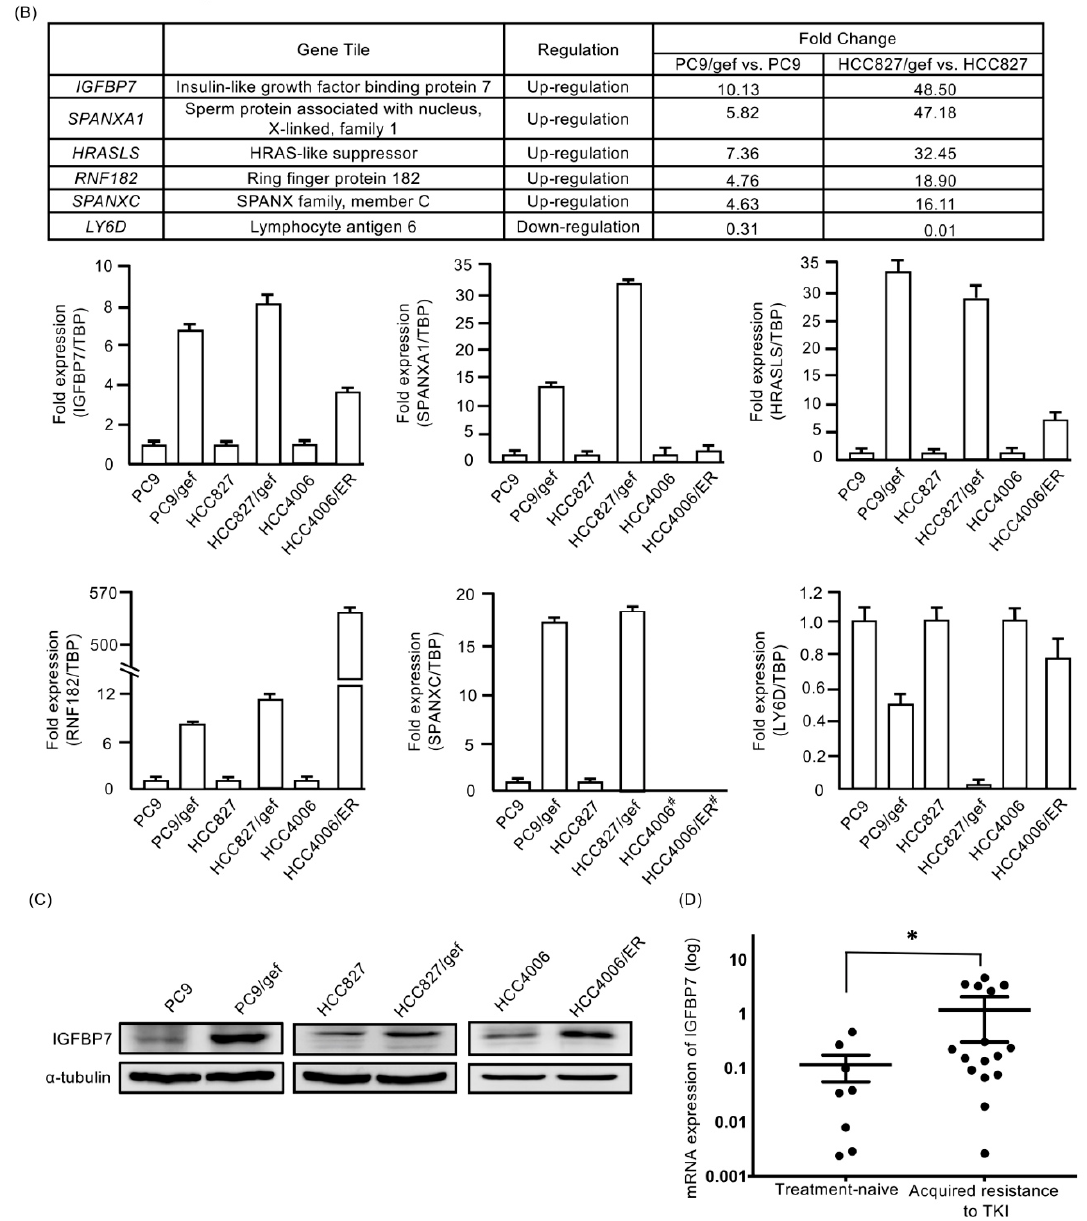
Figure 2. IGFBP7 was up-regulated in epidermal growth factor receptor (EGFR)-TKI-resistant cells. ( A ) Affymetrix GeneChip Arrays were performed to identify differentially expressed genes between EGFR-TKI-sensitive (PC9 and HCC827) and acquired EGFR-TKIs-resistant cell lines (PC9/gefitinib (gef) and HCC827/gef). ( B ) The top six differentially expressed genes are listed and were validated by quantitative RT-PCR. (The levels of SPANXC were too low to be detected). ( C ) IGFBP7 protein expression was detected by Western blot analysis. EGFR-TKI-sensitive cells (PC9, HCC827, and HCC4006); EGFR-TKI-resistant cells (PC9/gef, HCC827/gef and HCC4006/erlotinib (ER)). ( D ) IGFBP7 mRNA levels were detected by quantitative RT-PCR. The mean of the IGFBP7 expression level was higher in malignant pleural effusions of patients with lung adenocarcinoma after acquired resistance to EGFR-TKIs than in that of treatment-naïve patients. The scatter dot plot graph represents IGFBP7 expression, and the error bars represent standard errors of the mean. (* p = 0.021).